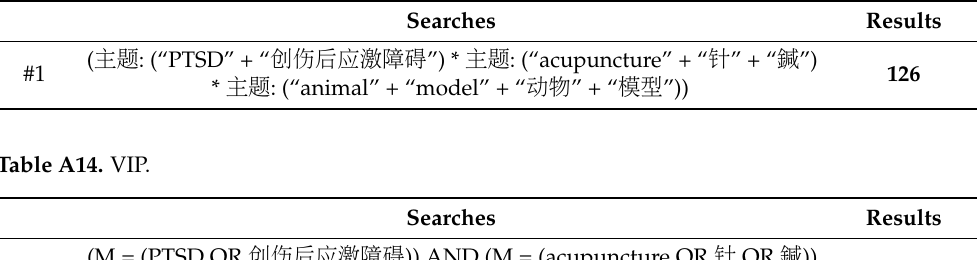
Table A13. Wanfang data.